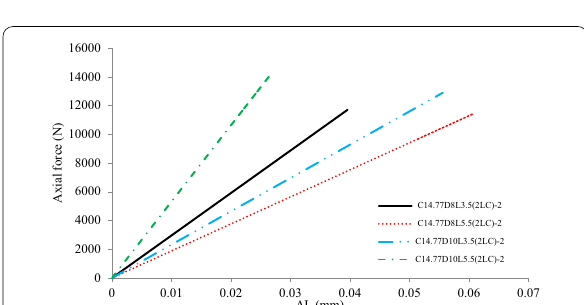
Fig. 13 Sliding force–deformation diagram in C14. 77D8L3.5-2LC-2 and C14.77D8L5.5-2LC-2, and C14.77D10L3.5-2LC-2 specimens.